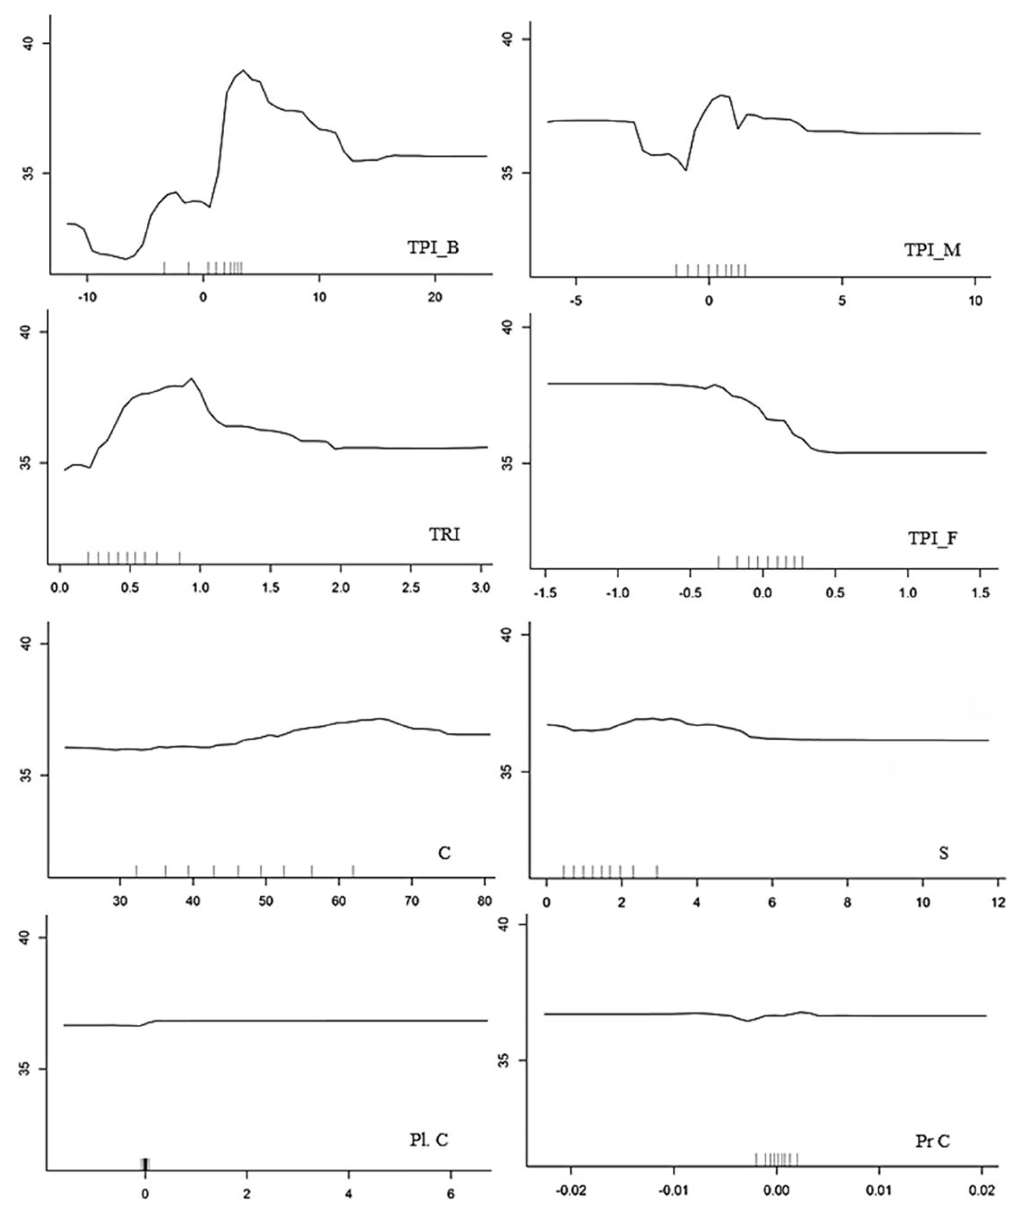
Figure B4. Partial dependence plots for each of the predictor variables. The y axis represents the number of Mn nodules m − 2 and the x axis the values of each predictor variable (depth derivatives). The ticks on the graphs indicate the deciles of the